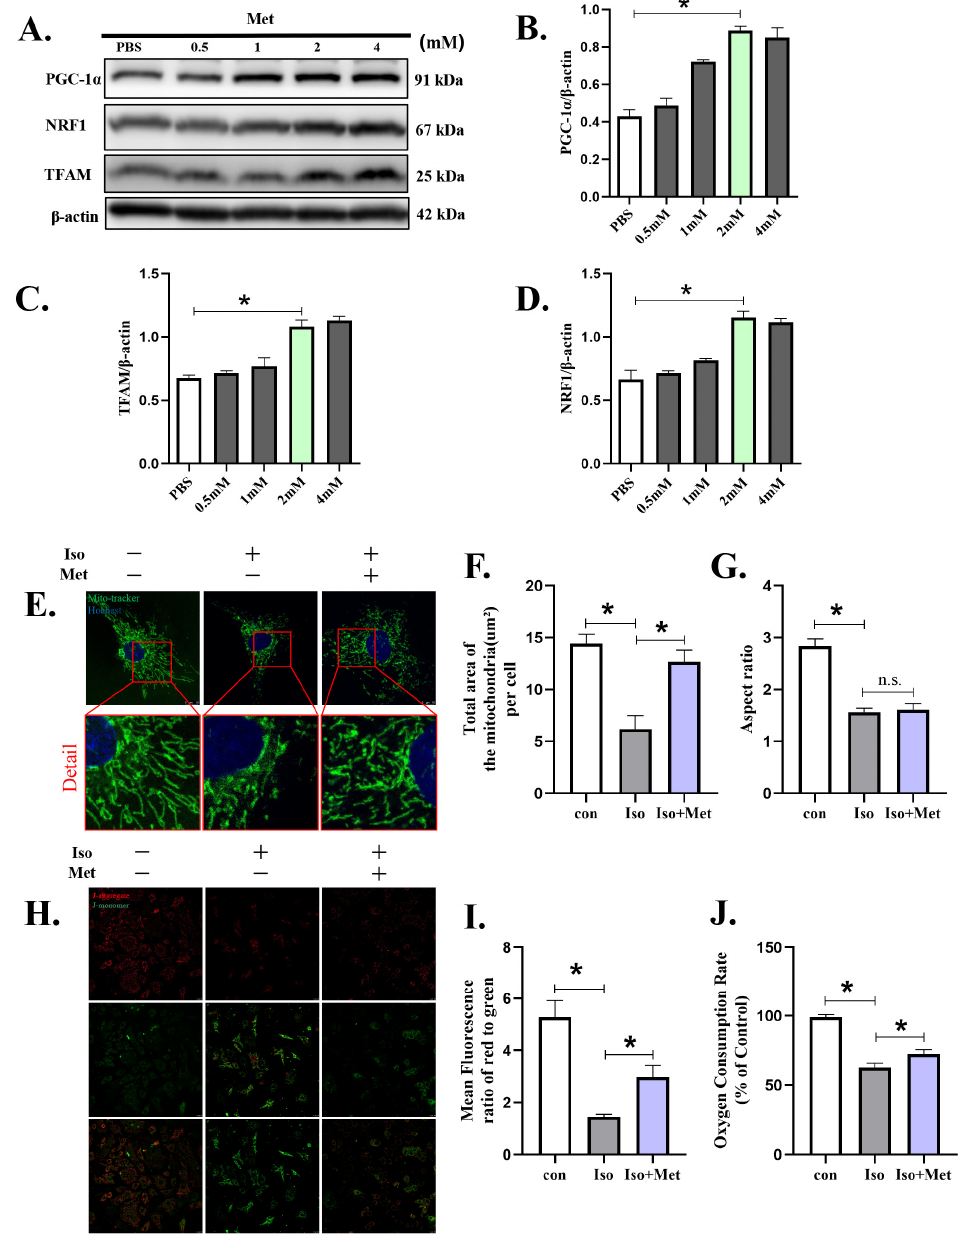
Figure 5. Metformin attenuated isoprenaline-induced cardiomyocyte injury by enhancing mitochon- drial biogenesis. Metformin was used to transfect cardiomyocytes and then stimulated with Iso (10 µM) for 48 h. ( A – D ) Western blot showing the expression of PGC-1 α , NRF1 and TFAM for the indicated time in cardiomyocytes. ( E – G ) Representative immunofluorescence images of mitochon- drial morphology. Mitochondria are shown in green, and nuclei are shown in blue. ( H , I ) Fluores- cence images of MMP was detected by JC-1 tracker. J-aggregate staining is shown in red and J- monomer staining is shown in green. ( J ) Mitochondrial respiration was measured using extracellu- lar oxygen consumption assay kits by assessing oxygen consumption rate. Statistical analyses ( A – J )